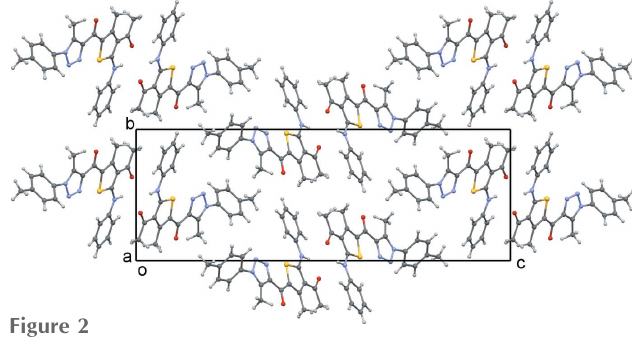
Figure 2 Crystal packing viewed down the a axis.